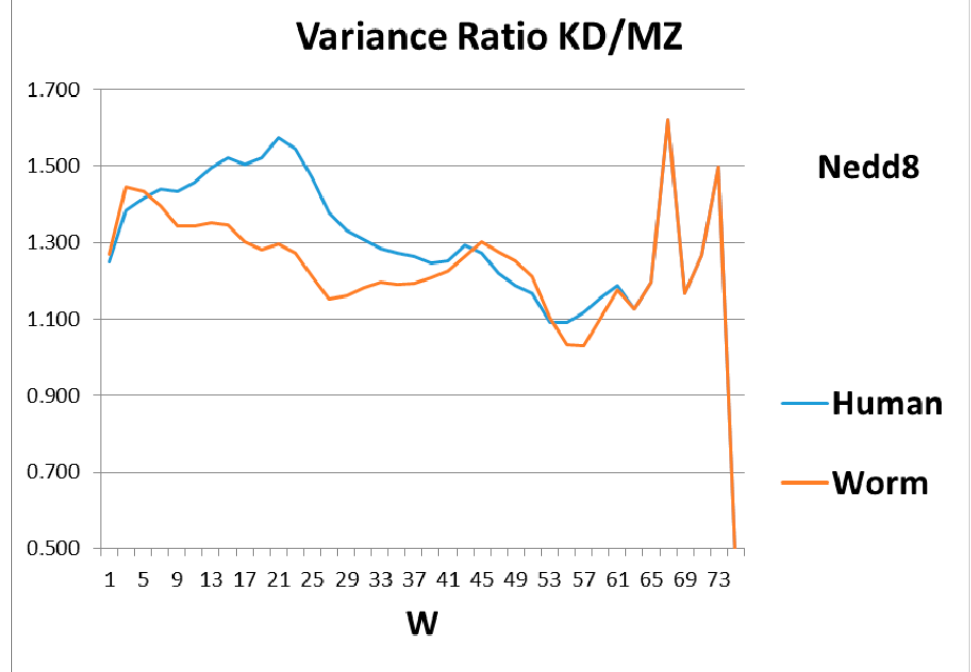
Figure 4. Comparison of the roughness (variance) of the hydropathic profiles for different sliding window wave lengths, W , for worm and human Nedd8 shows that evolution has mainly improved the shorter lengths, W ~20, while the peaks and anti-resonance seen in Figure 2 for ubiquitin are undeveloped.